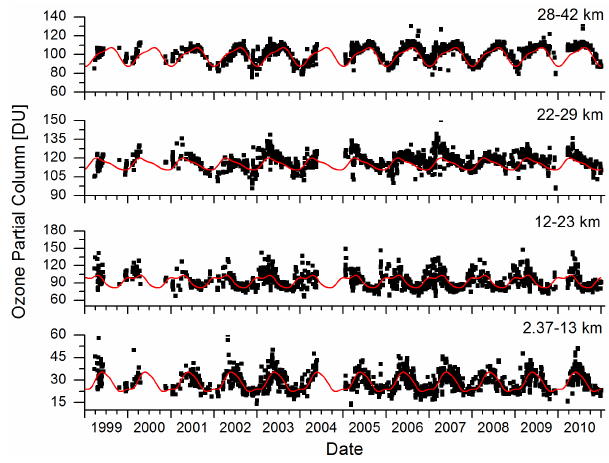
Fig. 11. Time series of FTIR ozone partial columns [DU] (setup C) for the different layers. Black dots: individual measurements ( N = 1887); Red lines: annual cycle according to Eq. (2).